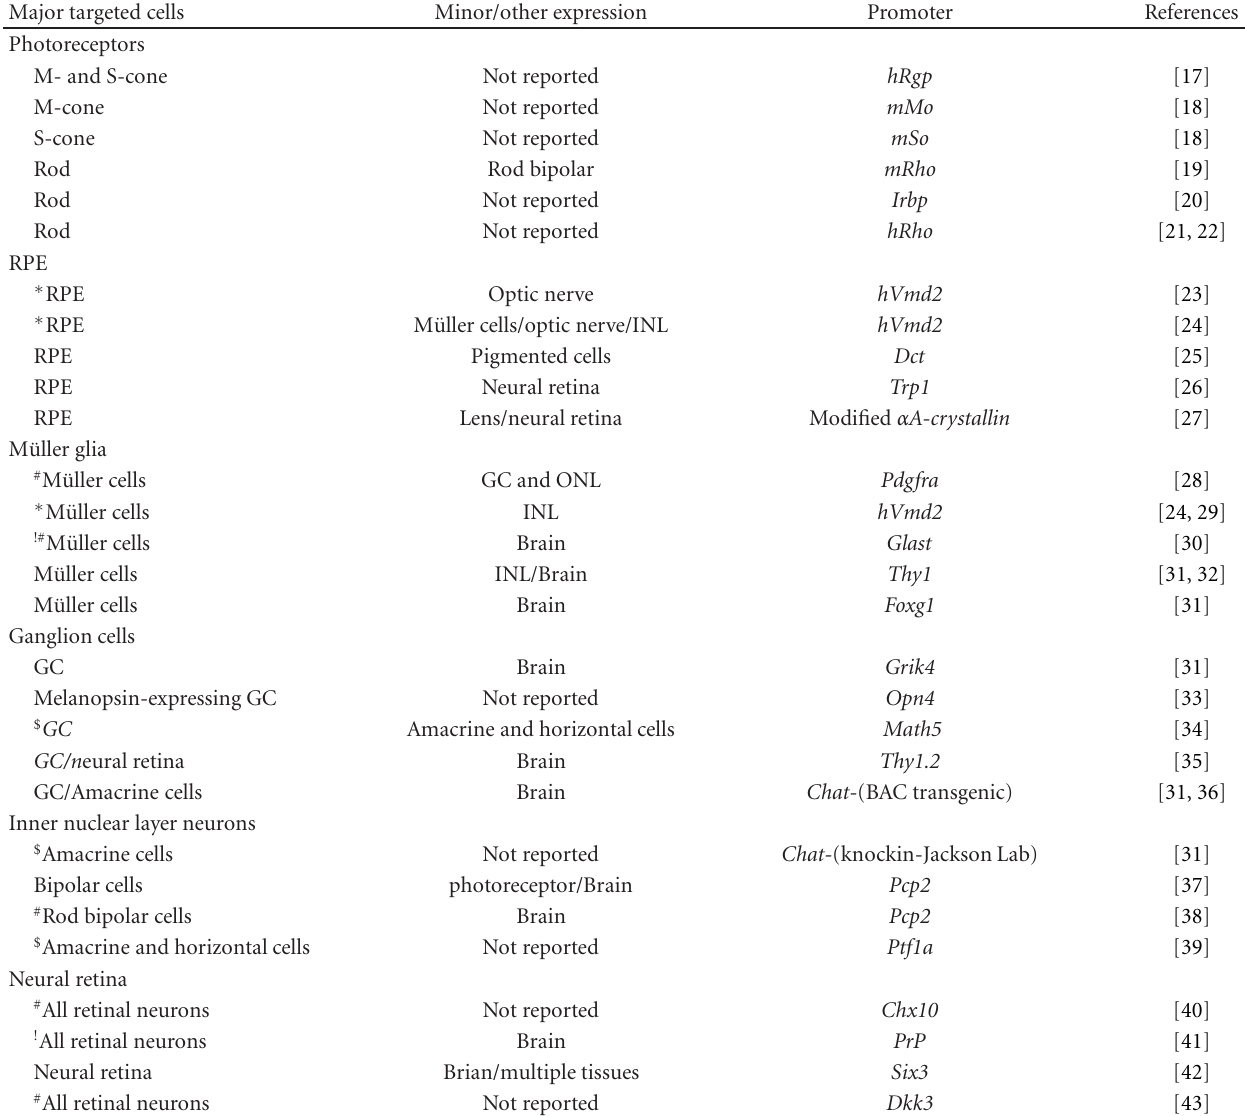
Table 1: Published potentially useful Cre-drive lines in designing studies related to retinal